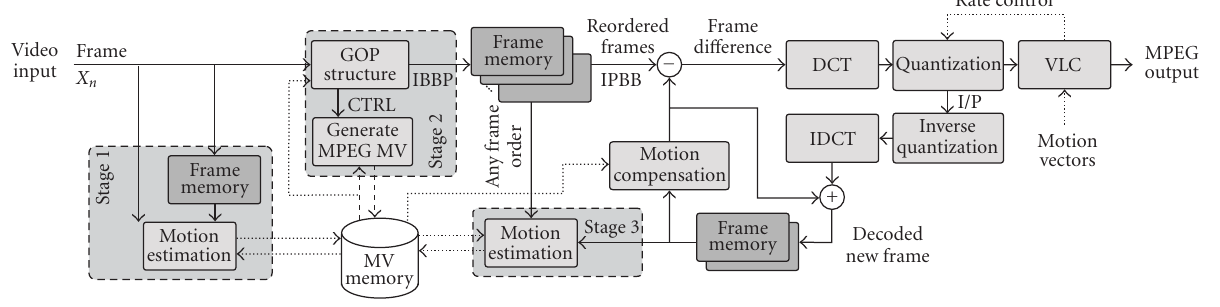
Figure 10: Architecture of an MPEG encoder with the new scalable three-stage motion estimation.